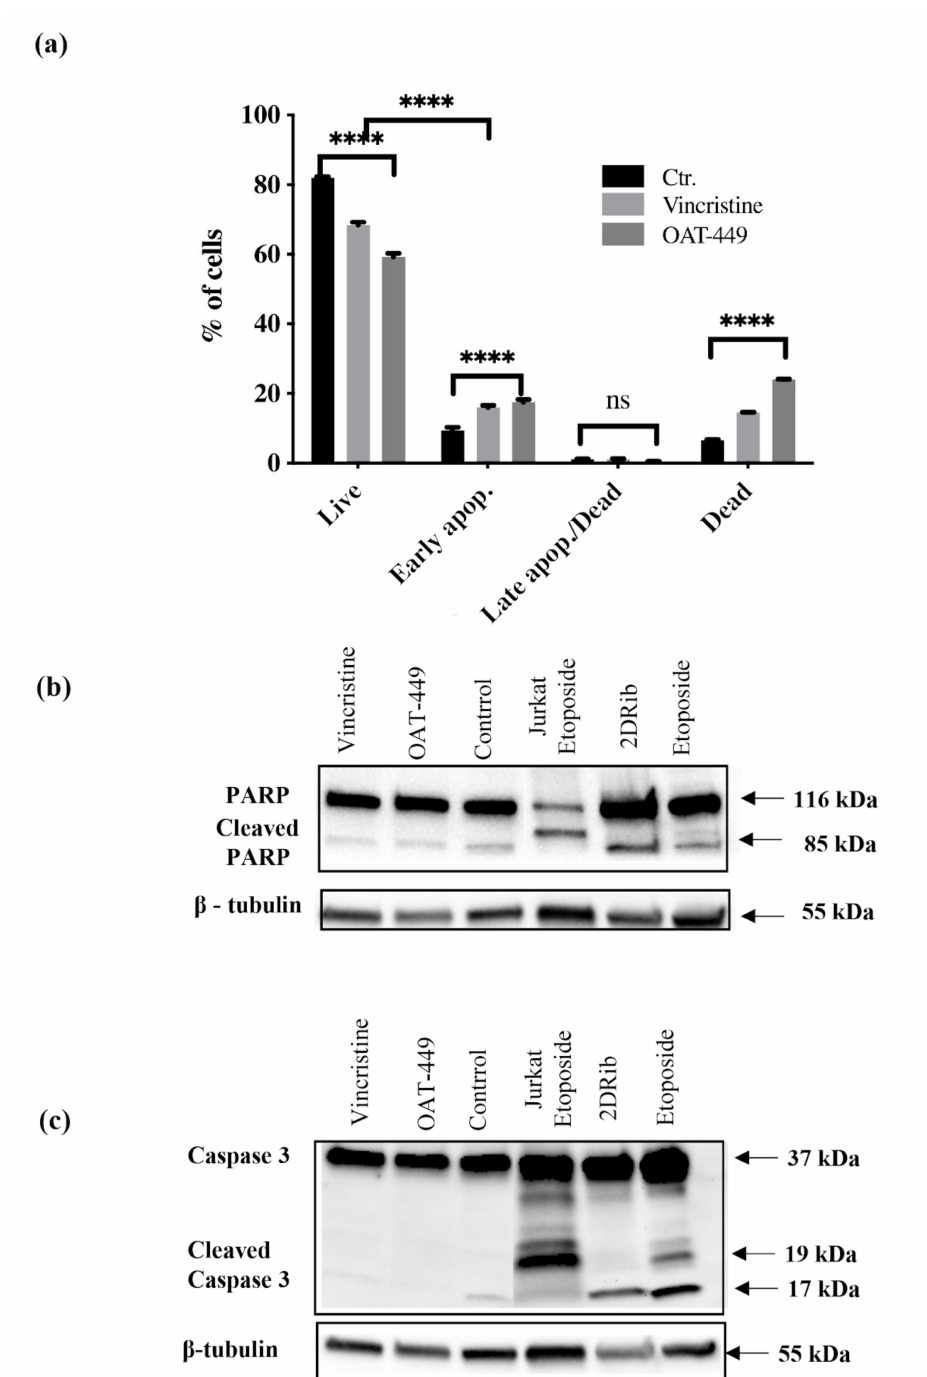
Figure 4. Lack of apoptotic response of HT-29 cells after treatment with OAT-449 or vincristine. ( a ) Cells were incubated for 18 h at initial density of 1 × 10 6 cells / mL in the absence or presence of 30 nM OAT-449 or vincristine. After treatment cells were stained with Annexin V-FITC. Data represent mean ± SEM of at least 3 independent experiments (**** p value < 0.0001). ( b ) Immunoblotting of PARP in HT-29 cells in basal conditions and upon treatment. ( c ) Immunoblotting of pro-apoptotic caspase-3 in whole cell lysate of HT-29 in basal conditions and upon treatment with OAT-449 or vincristine. 2-deoxy-D-ribose (2DRib) and etoposide were used as a positive controls in order to achieve activation of apoptotic response driven via cleavage of poly (ADP-ribose) polymerase (PARP) and caspase-3. β –tubulin used as a loading control. Blots are representative of 3 independent